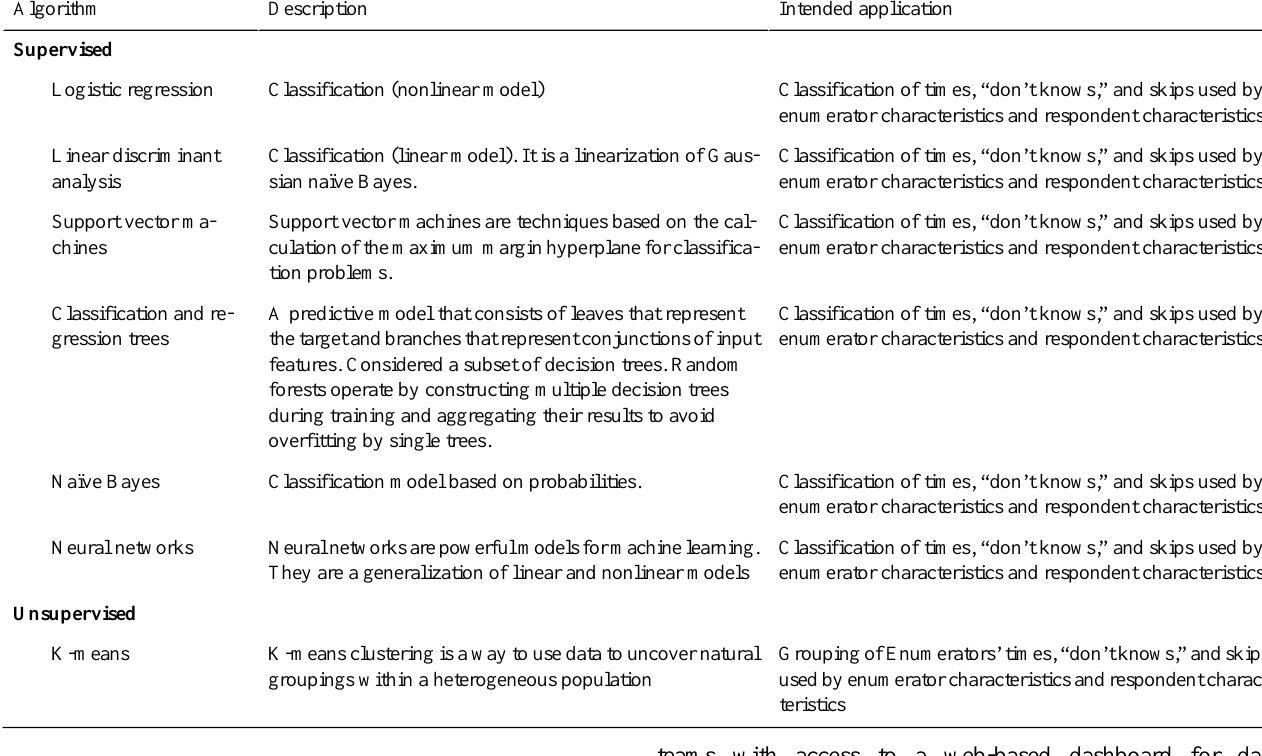
Table 2. Machine learning